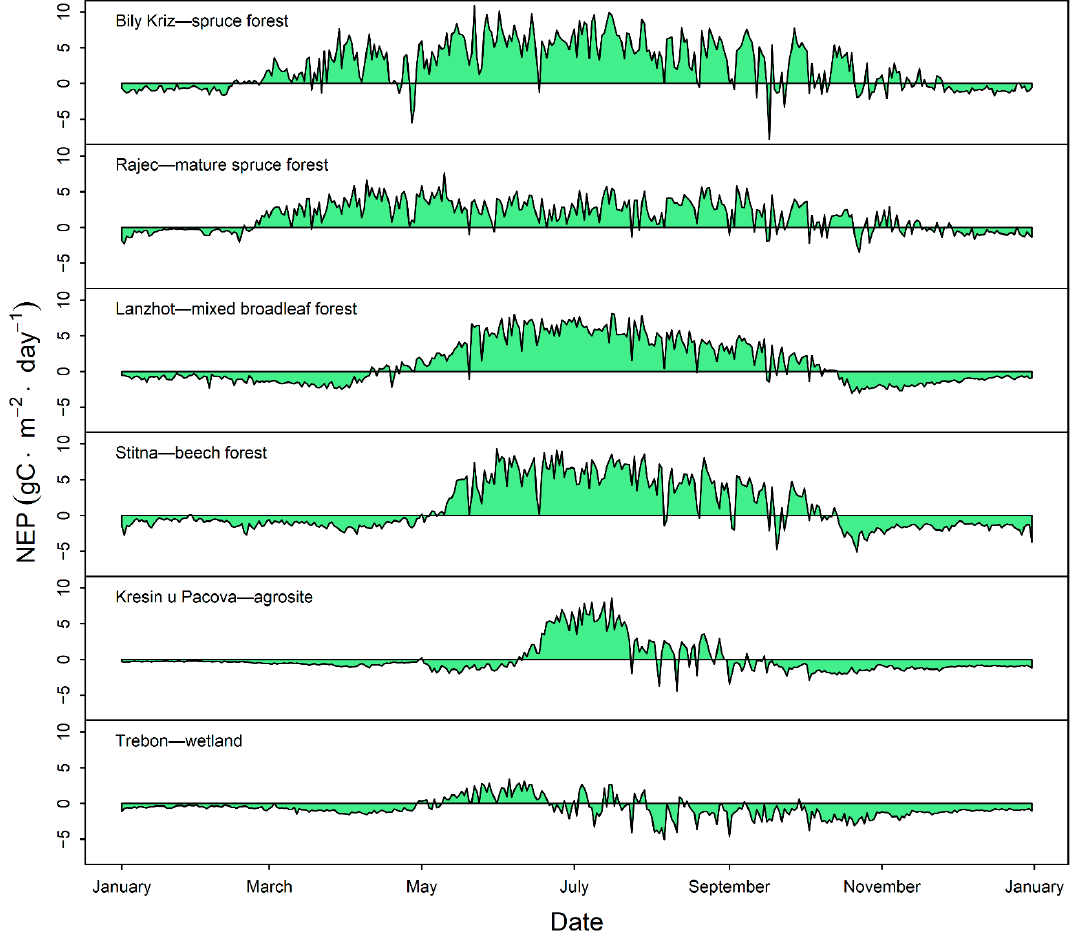
Figure 3. Comparison of annual course of net ecosystem production (NEP) for various ecosystems in the Czech Republic during the year 2018 (unpublished data Šigut et al.).